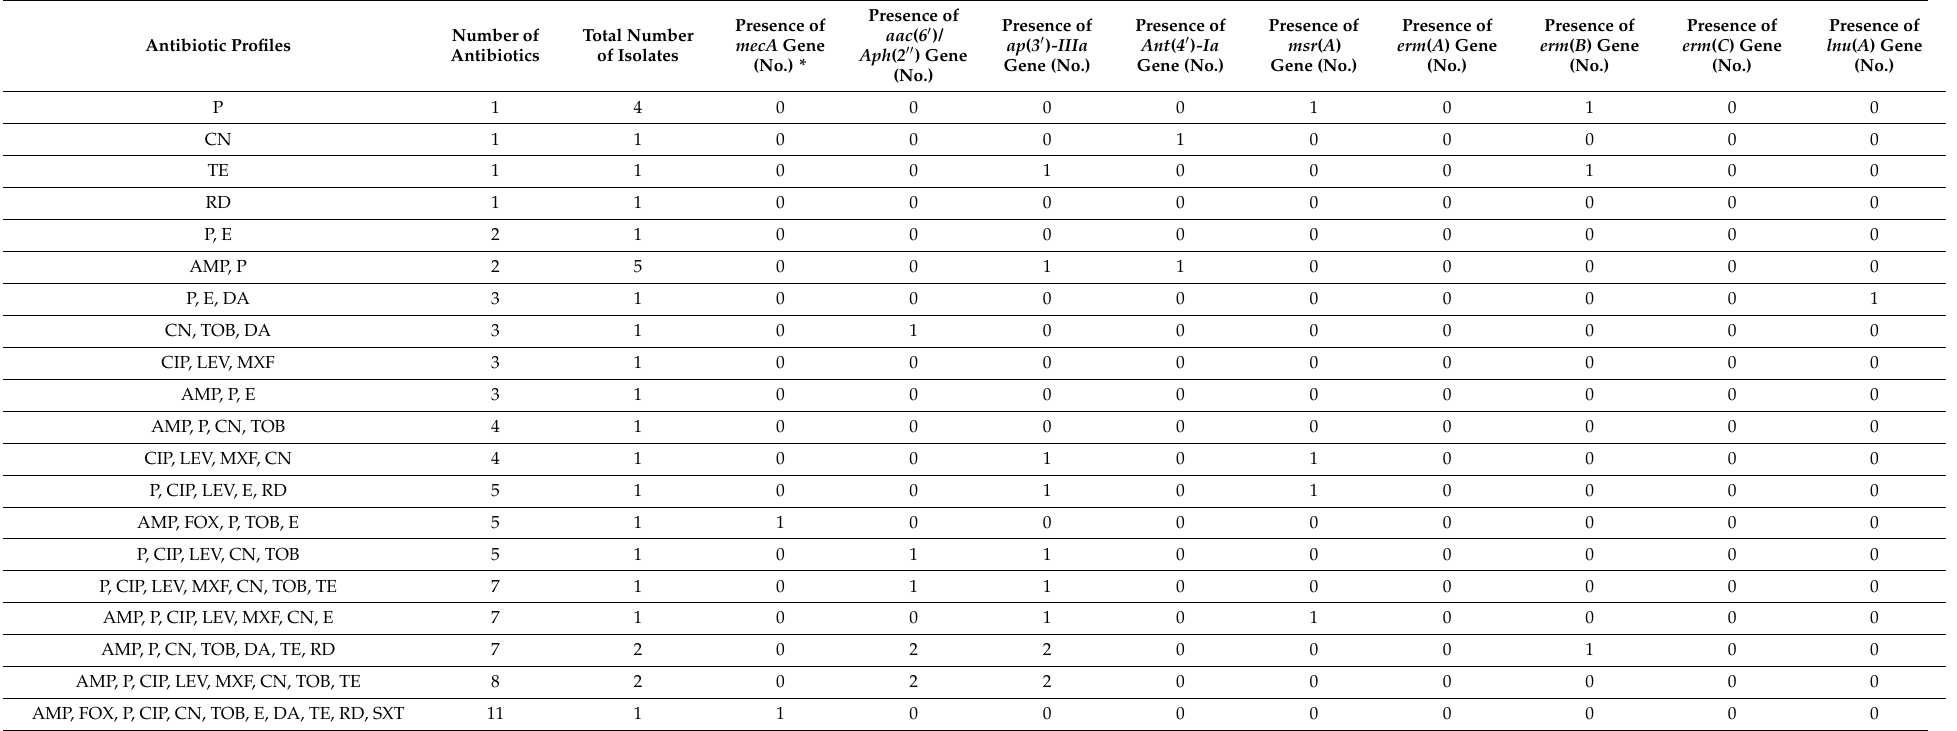
Table 2. Antimicrobial resistance and prevalence of antibiotic resistance genes among Staphylococcus aureus .